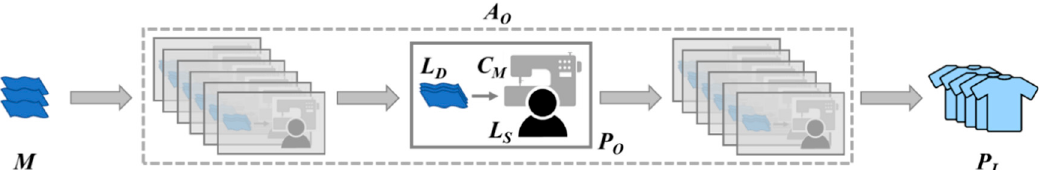
Figure 2. Factors a ff ecting performance in garment production Figure 2. Factors affecting performance in garment production lines. Figure 2. Factors affecting performance in garment production lines.